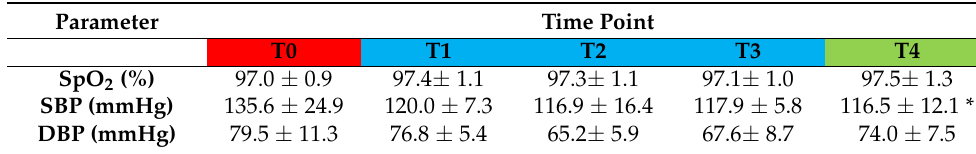
Table 1. Physiological parameters from all subjects at the baseline (T0) and during the season: SBP: Systolic Blood Pressure; DBP: Diastolic Blood Pressure; and SpO 2 : Arterial Oxygen Saturation. Data are displayed as mean ± SD. Statistically significant differences symbols: * p < 0.05 respect T0. The colors of the time boxes (from T0 to T4), are the same as those reported in the histograms of figures from 2 to 4, to help the reader.